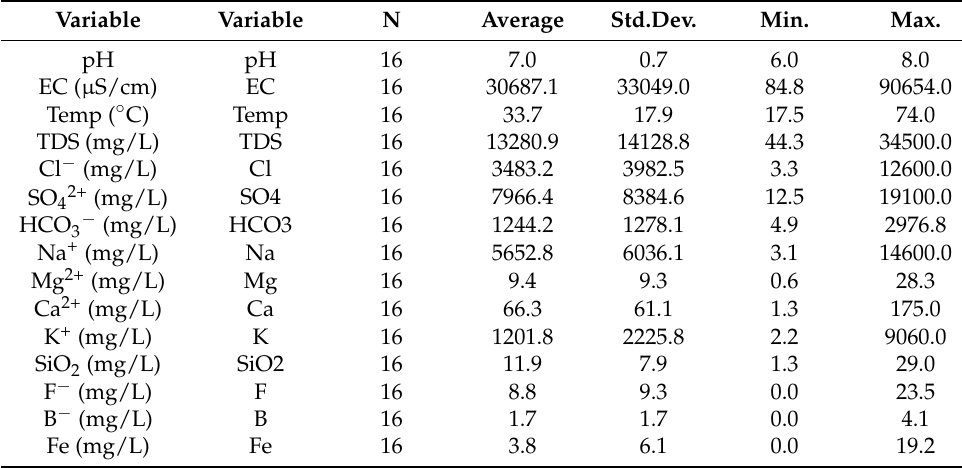
Table 4. Descriptive statistics of hydrothermal water samples from